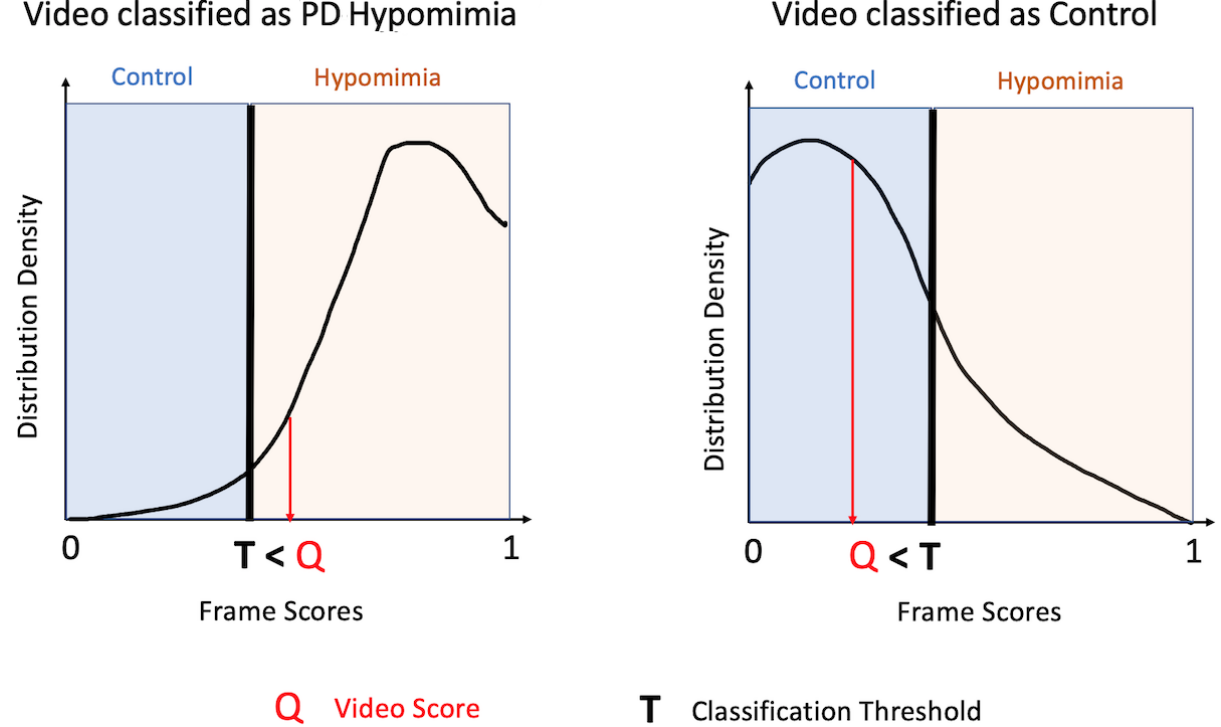
Figure 2. Video scoring. To classify a video, a probability distribution is created for all of a video’s frames, and the fifth percentile of the distribution is defined as Q. A video that has a Q value above T (ie, closer to 1 or more evidence of hypomimia) is categorized as PD hypomimia; a video with a Q value below T (ie, closer to 0 or less evidence of hypomimia) is categorized as Control. PD: Parkinson